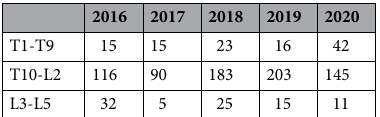
Table 2. Fractured vertebral levels in OVCF patients over 5 years.